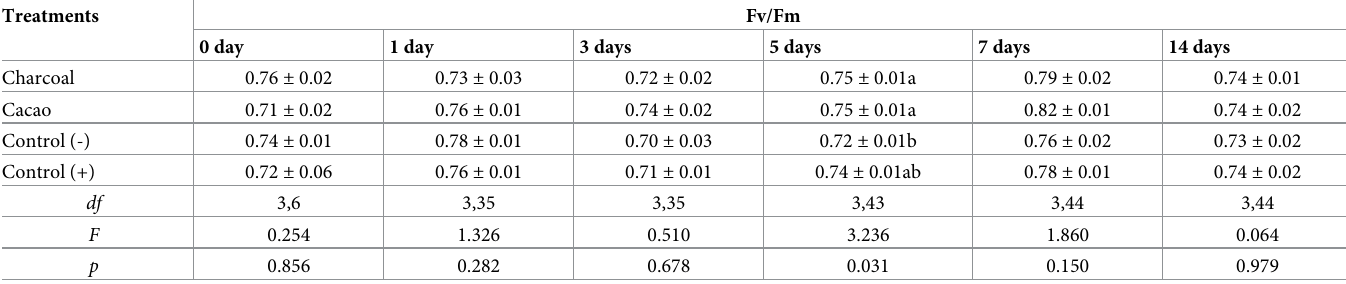
Table 2. Maximum photochemical efficiency (Fv/Fm) values (Mean ± SD) between treatments after 1, 3, 5, 7 and 14 days after application in 2018 trial.